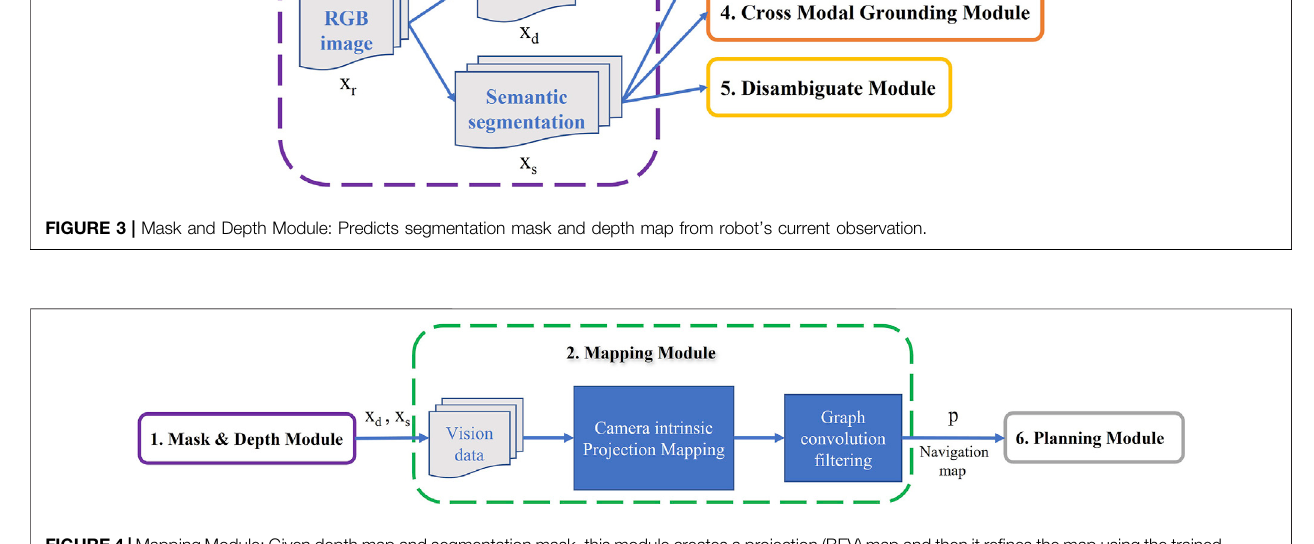
Frontiers in Robotics and AI |